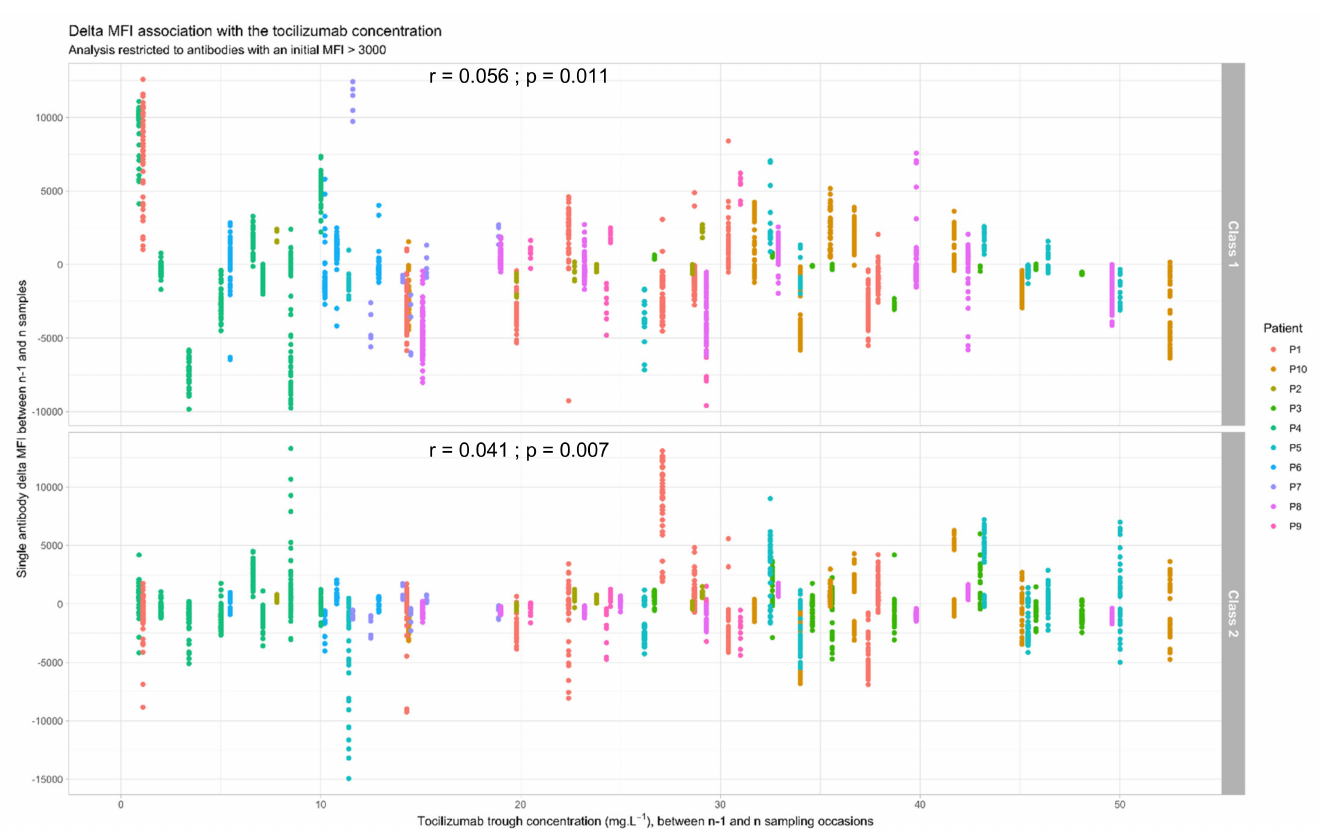
Figure 3. Concentration-effect relationship between tocilizumab trough concentration and the associ- ated MFI reduction for individual antibodies. MFI: mean fluorescence